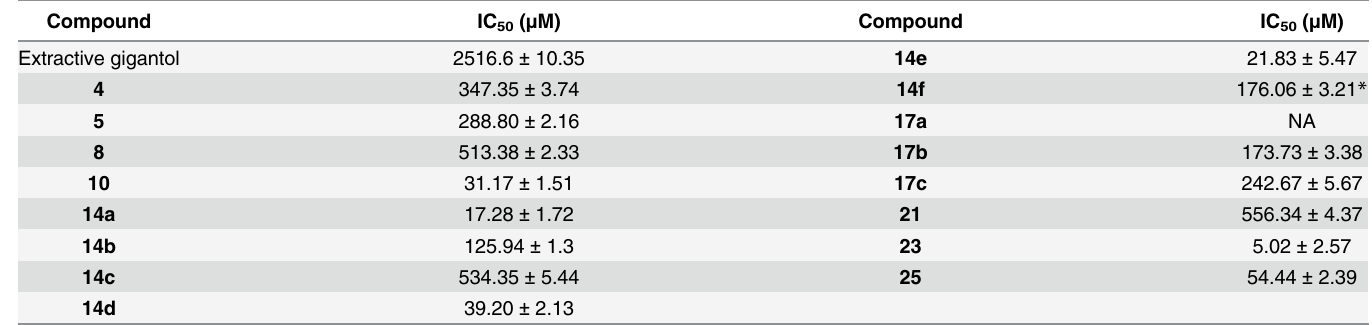
Table 1. Inhibitory effect of gigantol and its analogs on AR activity 1 .